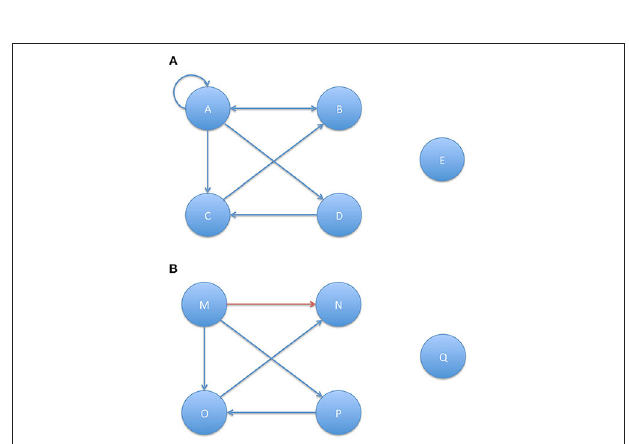
FIGURE 39 | Number of papers being cited over the years for the eight most important conferences.